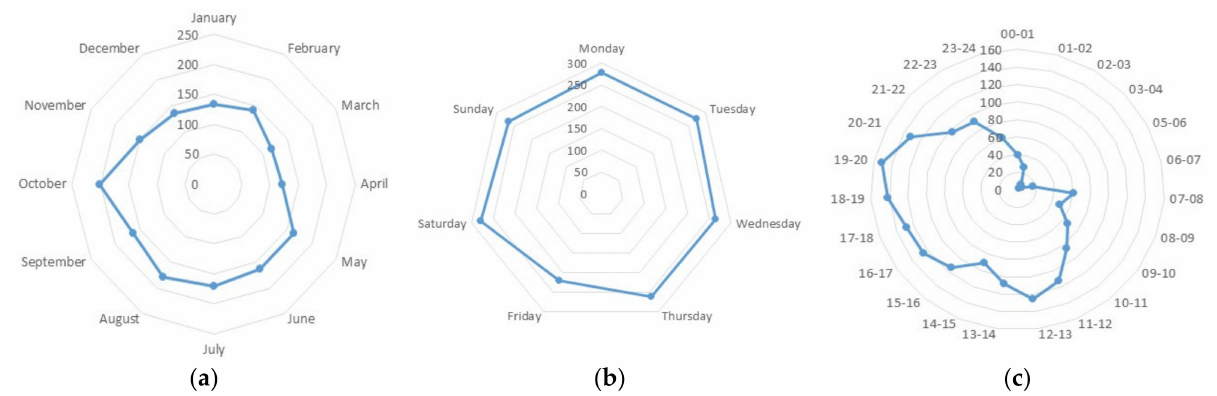
Figure 2. Distribution of road accidents (absolute number) in Zanjan city by month ( a ), weekday ( b ) and time ( c ).